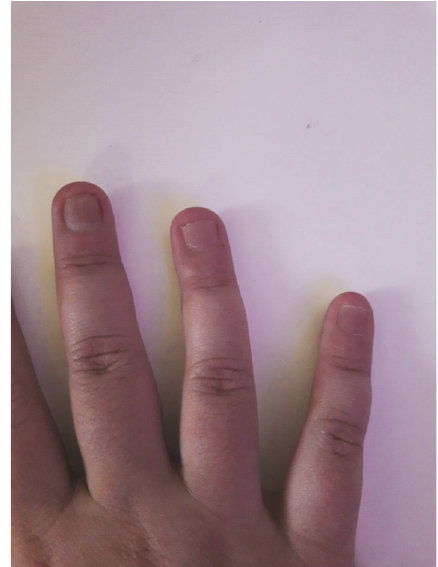
Figure 4: Recovery of nail psoriasis and normal appearance of the nails with a very good response to 22 months of adalimumab